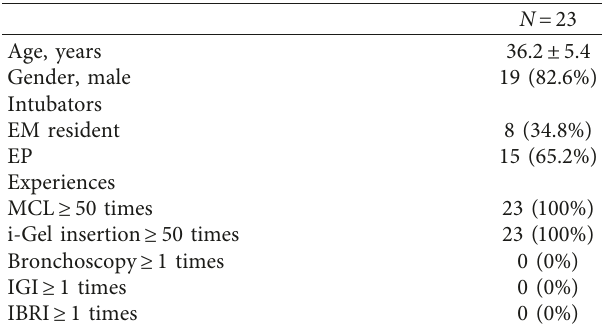
Table 1: Baseline